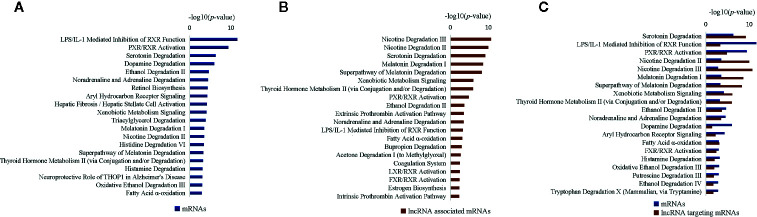
Most significantly affected canonical pathways of differentially expressed genes (DEGs) between Zucker control lean (ZCL) and Zucker diabetic fatty (ZDF) rats. (A) Top 20 most significantly affected IPA canonical pathways of differentially expressed mRNAs. (B) Top 20 most significantly affected IPA canonical pathways of mRNAs targeted by differentially expressed lncRNAs. (C) Top 20 most significantly affected IPA canonical pathways of differentially expressed mRNAs, as well as mRNAs targeted by differentially expressed lncRNAs. The y-axis indicates the significance (-log10(p-value)>1.3) of DEG-enriched pathways.